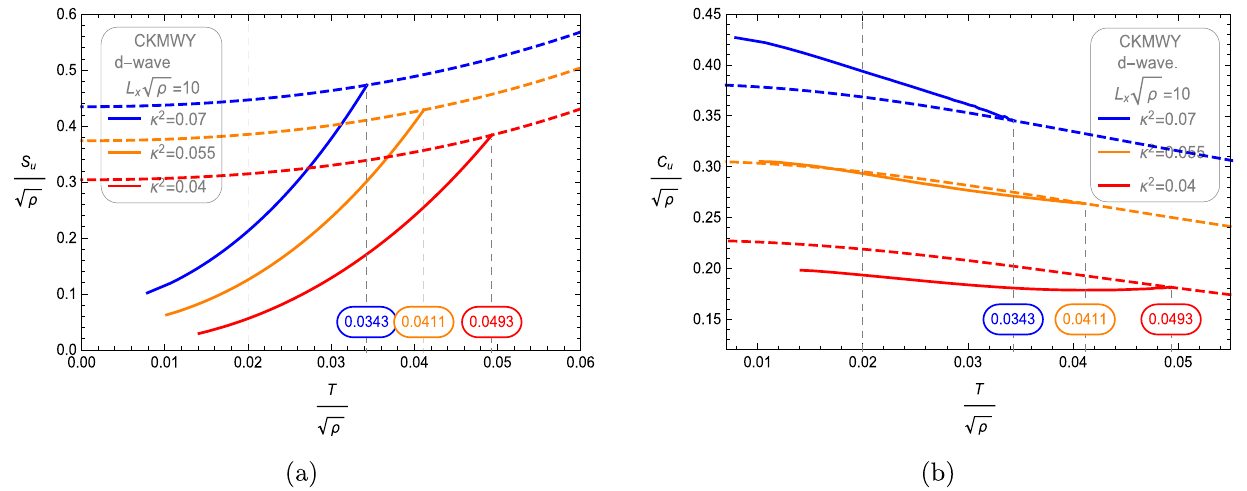
√ ρ for the CKMWY d-wave superconductor with a fixed subregion L